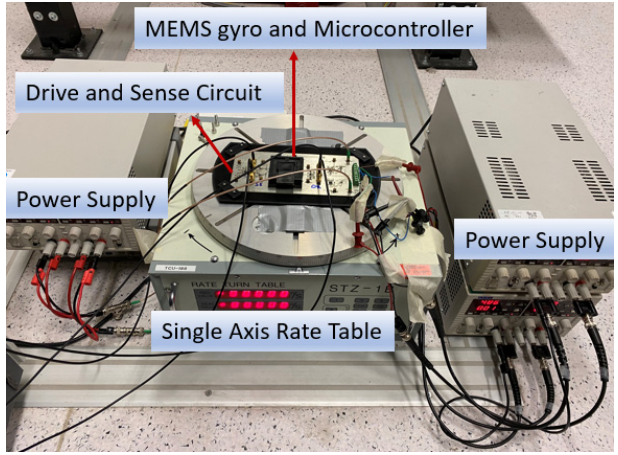
Figure 10. Experimental Setup.